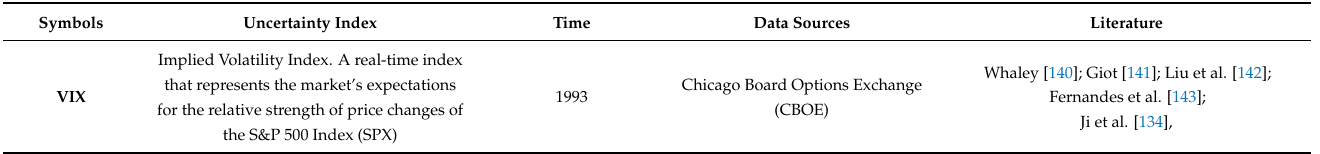
Table 3. Uncertainty Indices, Time span, Data and